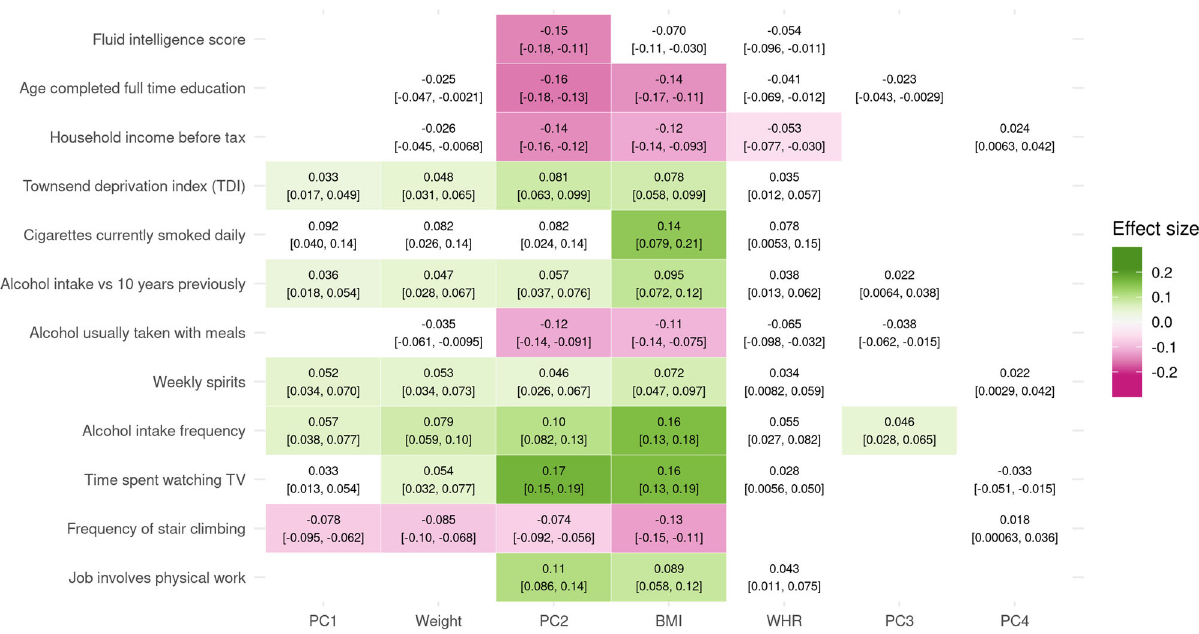
Fig. 5 Single and composite traits affect many aspects of lifestyle. Mendelian randomization causal effects of traits and principal components (PCs) on a selection of lifestyle factors on a standardized scale. The 95% con fi dence interval of the effect is indicated in brackets. Effects that were not signi fi cant at the Bonferroni-corrected threshold ( p < 7.1 × 10 − 5 ) are colored in white. The full list of effects can be found in Supplementary Data